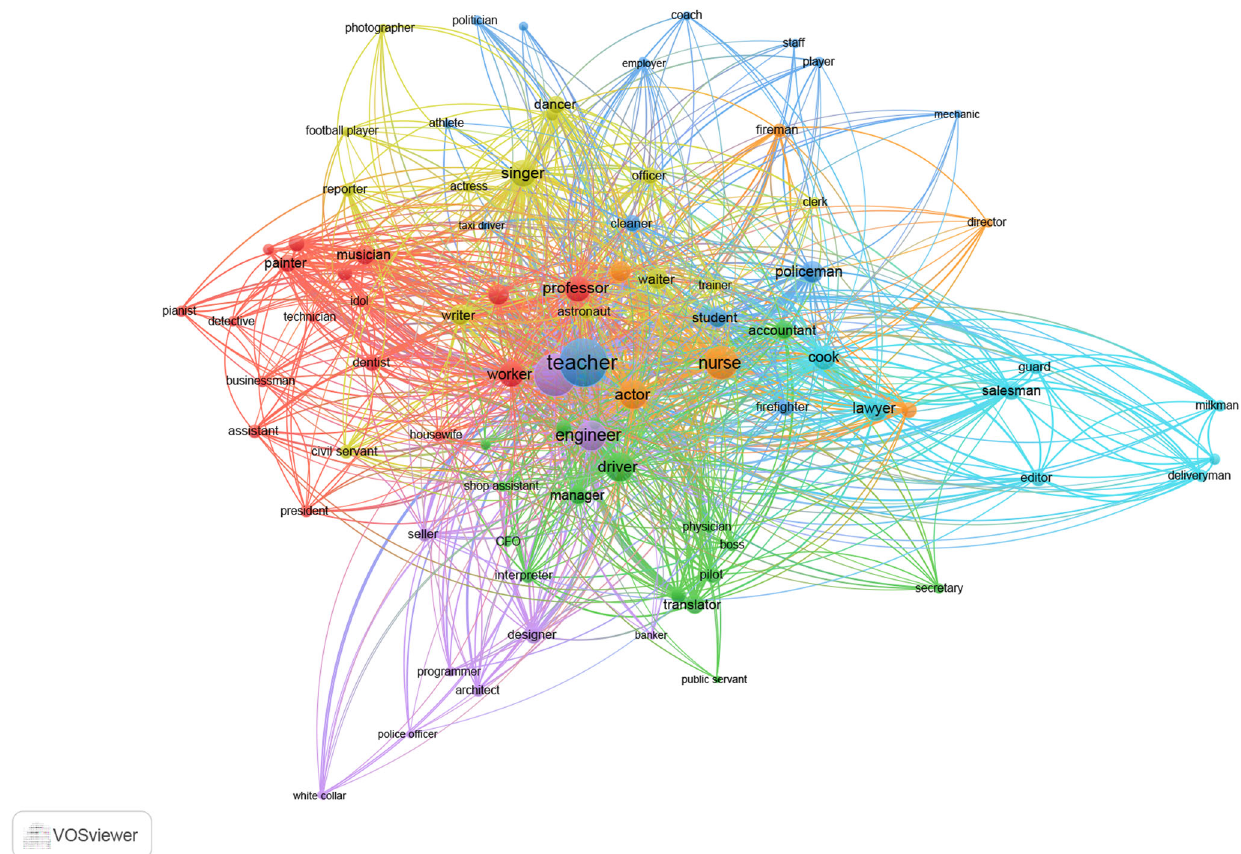
Fig. 4 The L2 lexical-semantic networks of the graduates (nodes ’ frequency above 2). The size of nodes represents the number of links and the color of links signi fi es clusters.